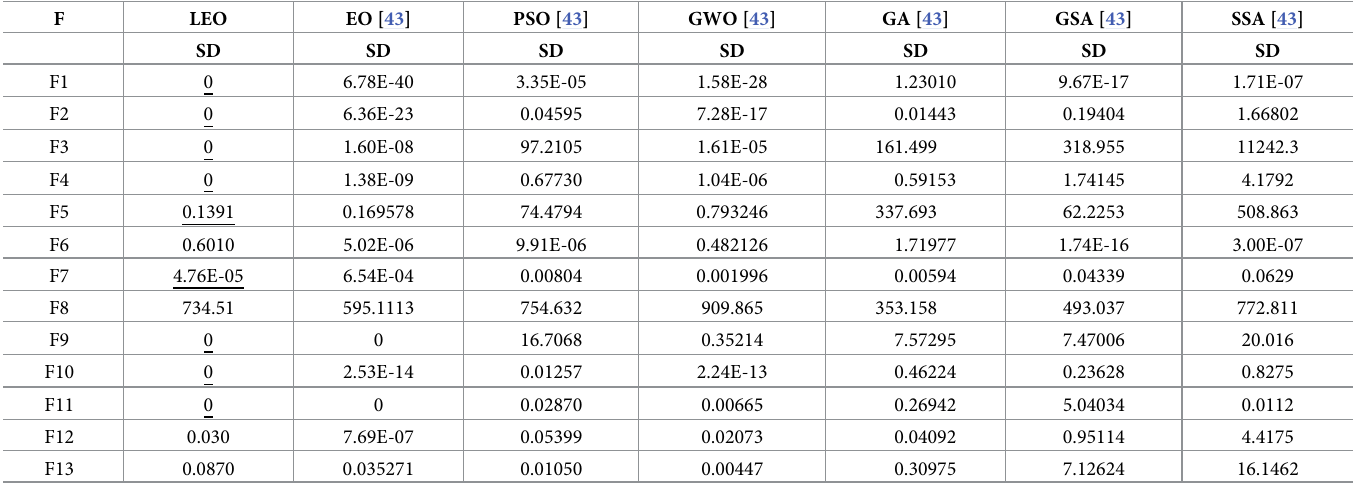
Table 4. Standard deviation of benchmark